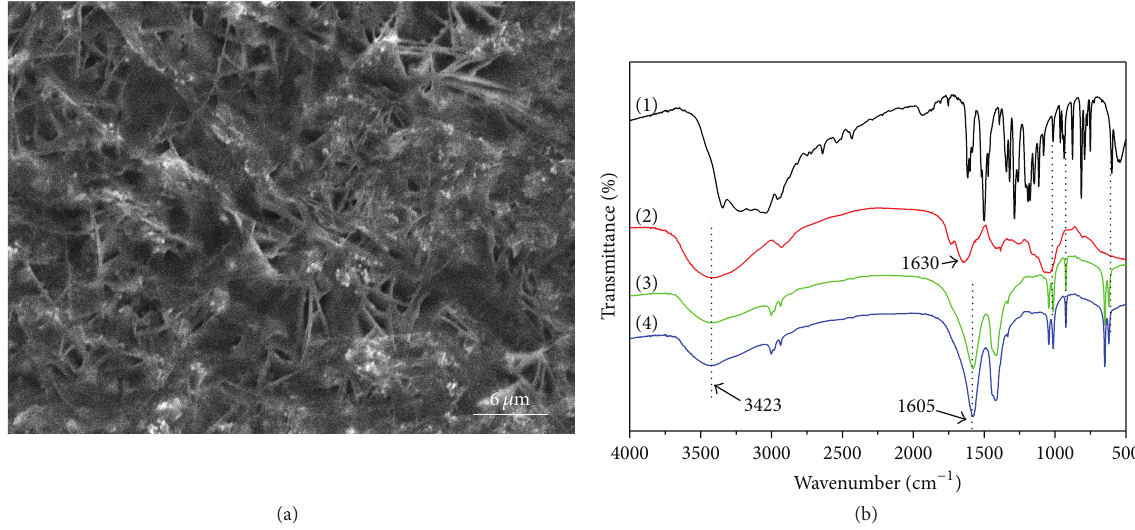
Figure 3: (a) SEM image of the surface of PDA-Lac-rGO-Pd/GCE; (b) FT-IR spectra of (1) DA, (2) Lac, (3) PDA-Lac composite, and (4) PDA-Lac-rGO-Pd composite.